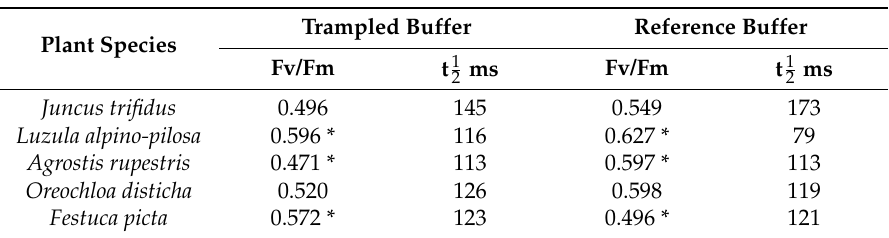
Table 5. The average fluorescence value for the studied species in the two buffers after adaptation to darkness (*—statistical significance at the 0.05 level).